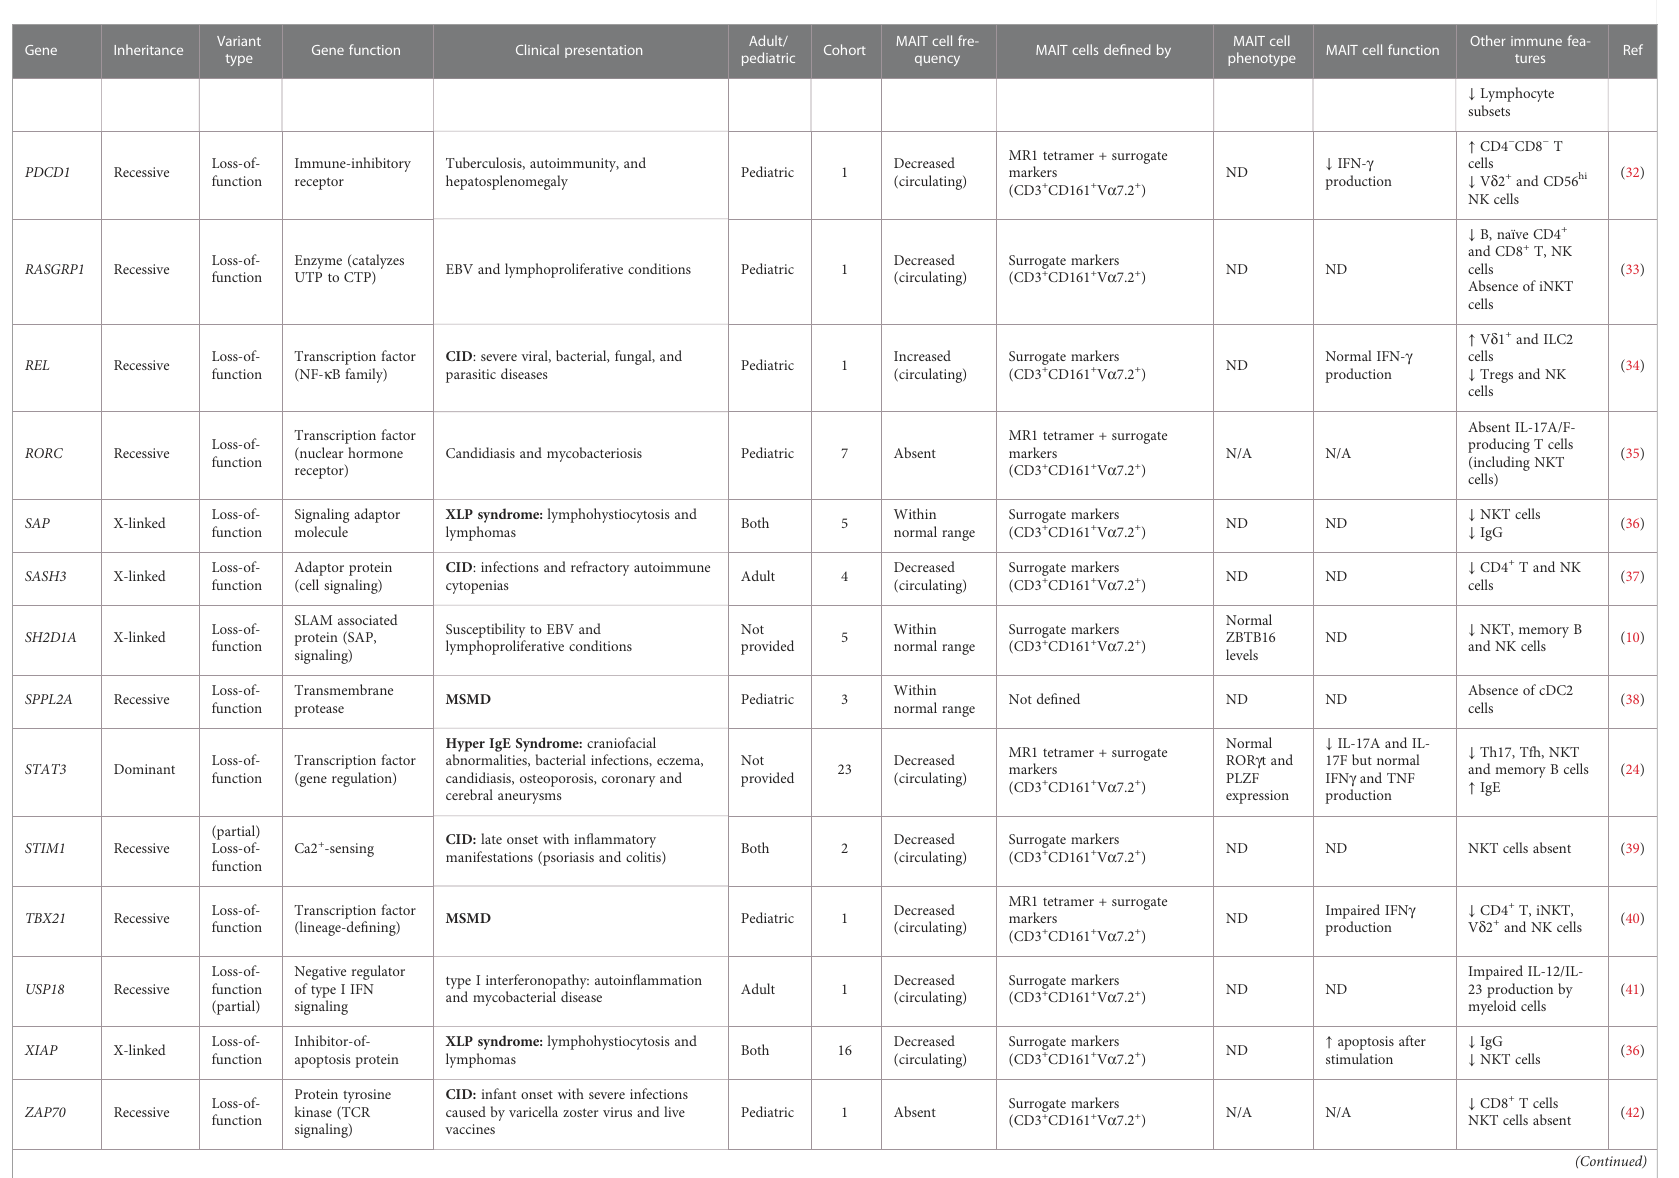
CID: infant onset with severe infections Protein tyrosine kinase (TCR caused by varicella zoster virus and live signaling) vaccines